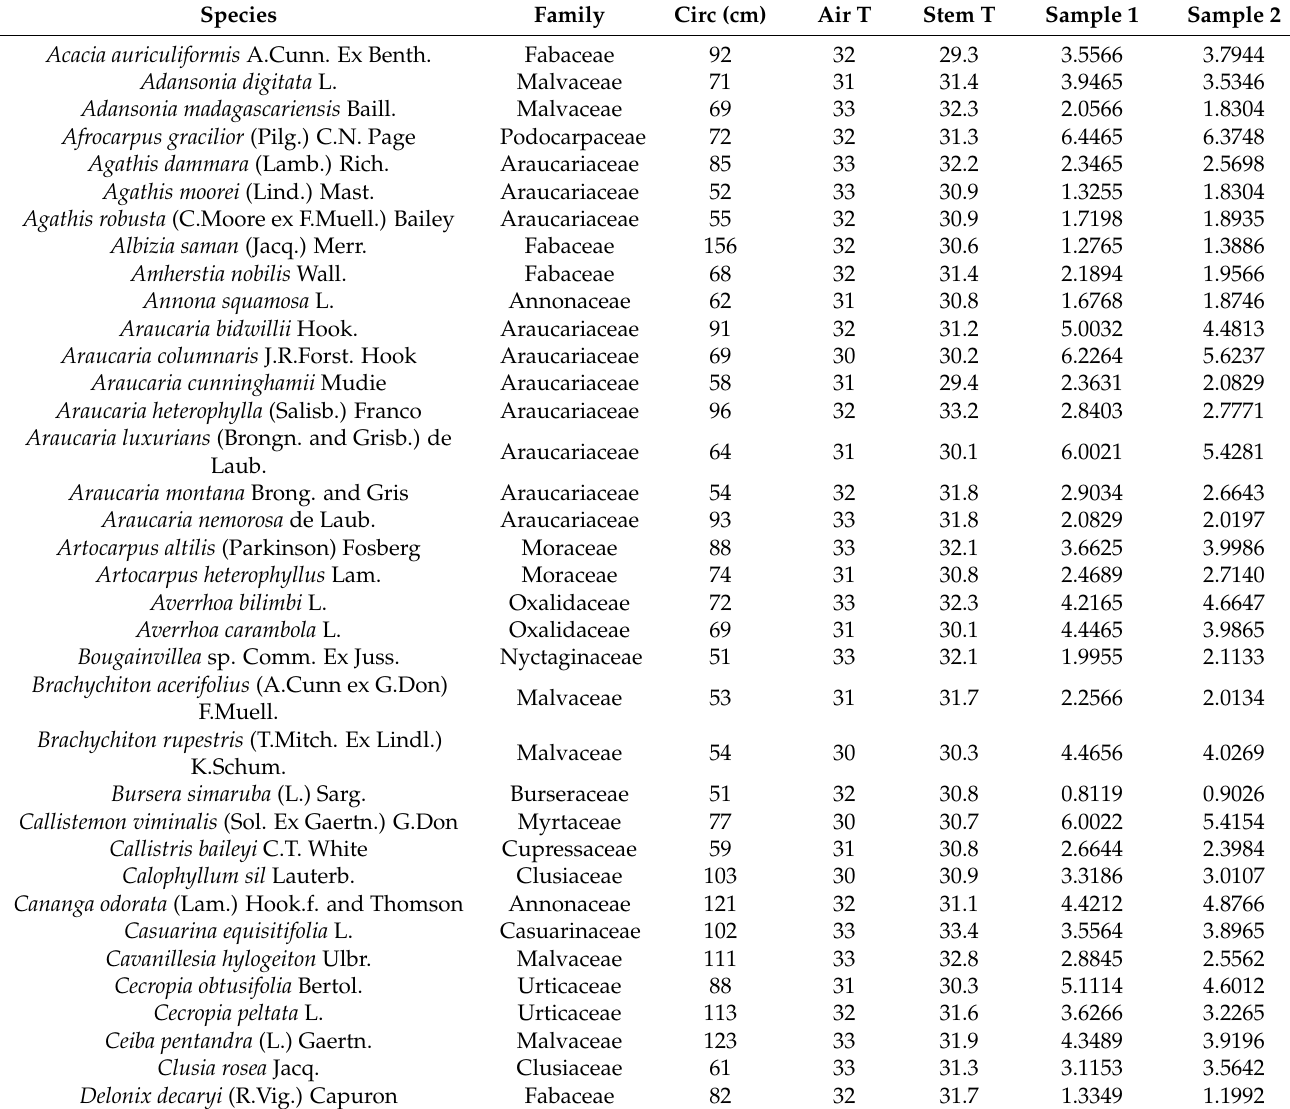
Table A2. List of the lignophyte species included in the carbon dioxide efflux study. Circ = circumfer- ence, Air T = air temperature, and Stem T = surface temperature of stems. Species